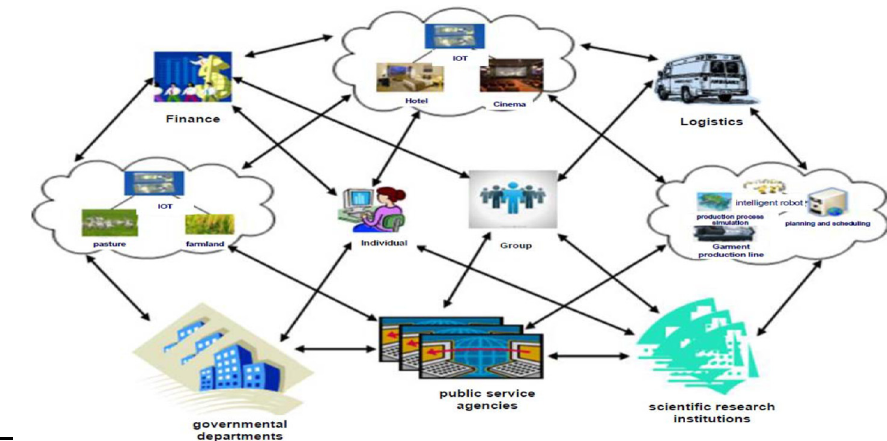
Figure 2. Schematic diagram of crowd cyber